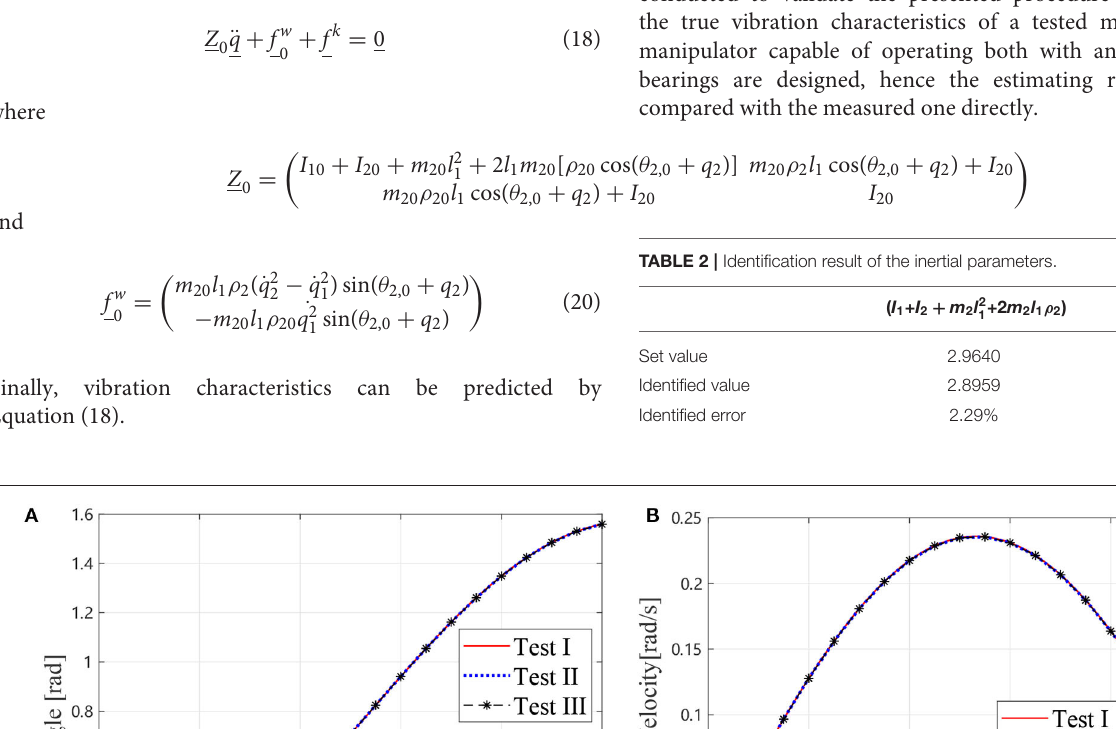
Frontiers in Robotics and AI |